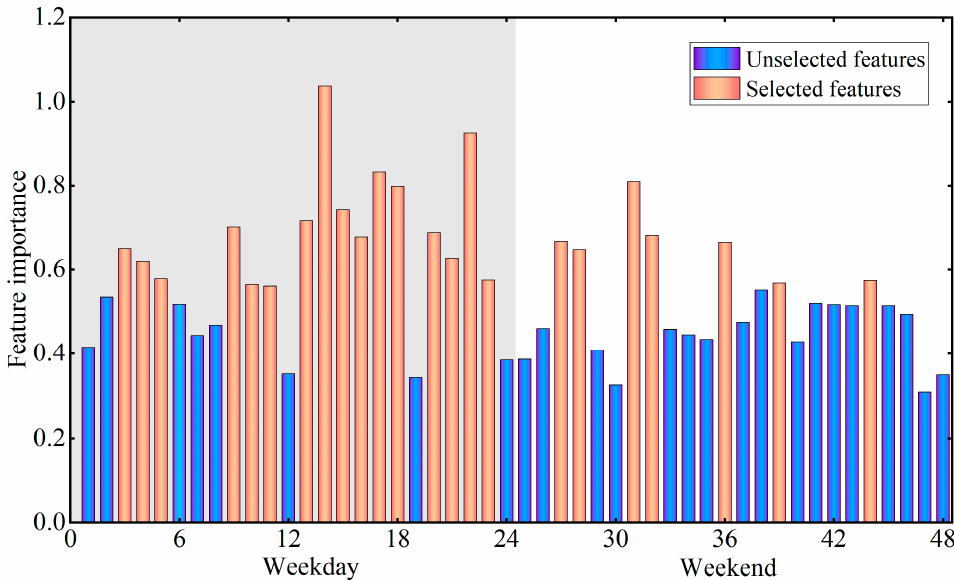
Figure 11. Importance ranking of MS input features.